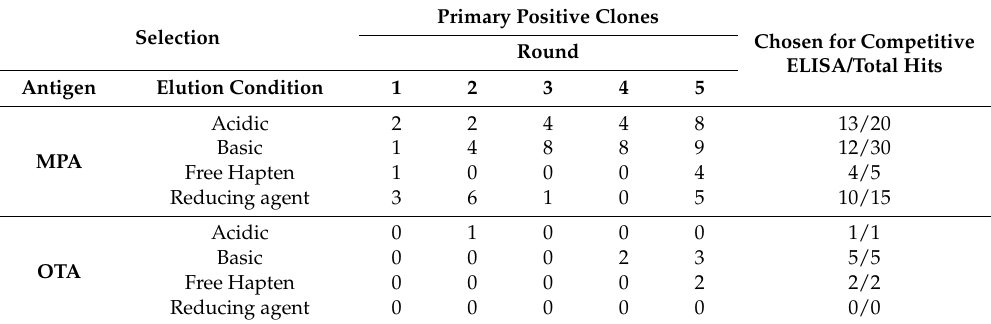
Table 2. Number of obtained positive ELISA hits from primary screening. MPA, mycophenolic acid; OTA, ochratoxin A. Primary Positive Clones Selection